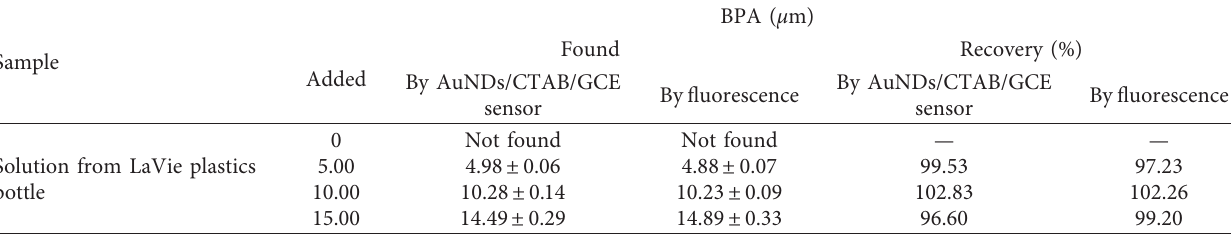
Table 2: Determined BPA concentrations spiked in the real sample using AuNDs/CTAB/GCE and by Fluorescence methods.